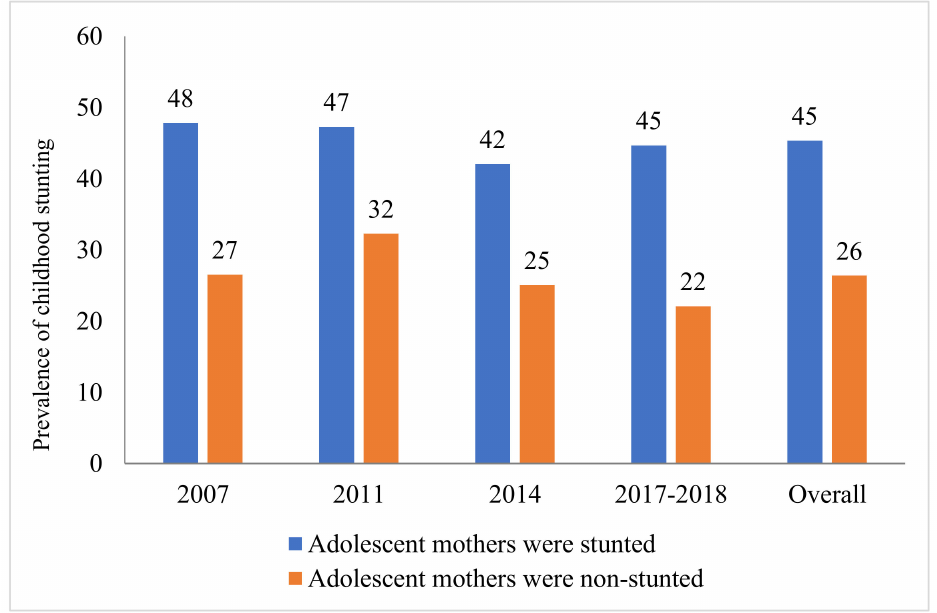
Figure 3. Status of childhood stunting by maternal stunting stratified by category round of the BDHS